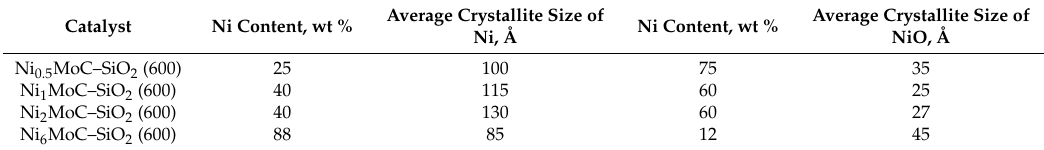
Table 2. Phase composition and average crystallite sizes for calcined Ni x MoC–SiO 2 (600) catalysts.